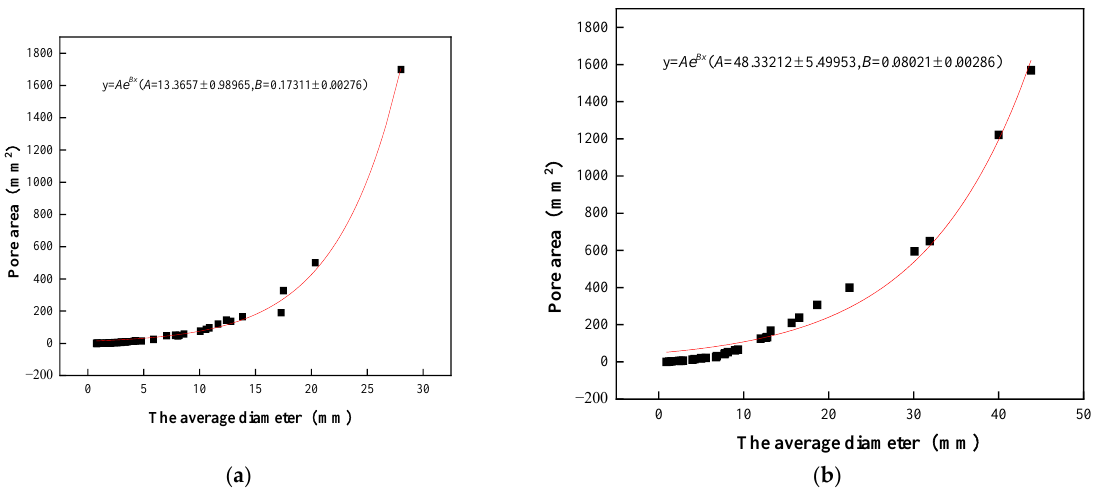
Figure 8. Average diameter in relation to planar pore area: ( a ) 10 – 30 aggregate gradation; ( b ) 20 – 40 aggregate gradation.